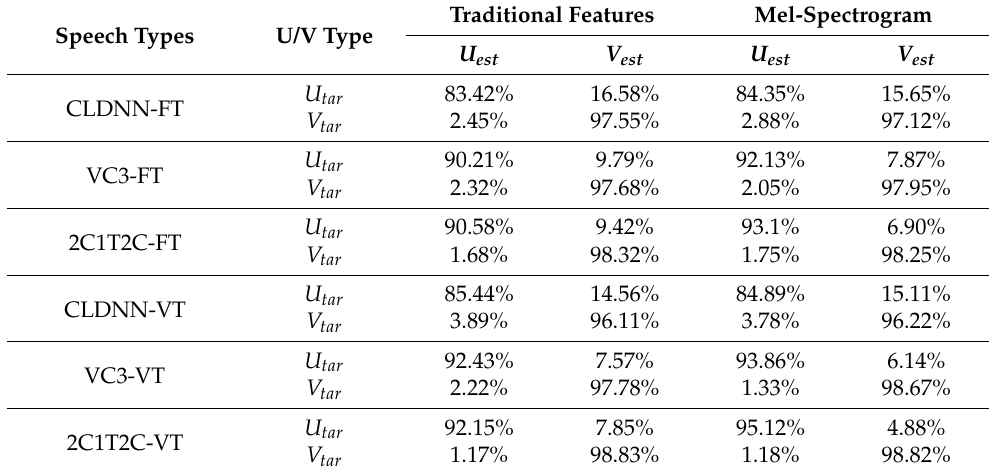
Table 2. U/V analysis for continuous Mandarin EL speech under different approaches.